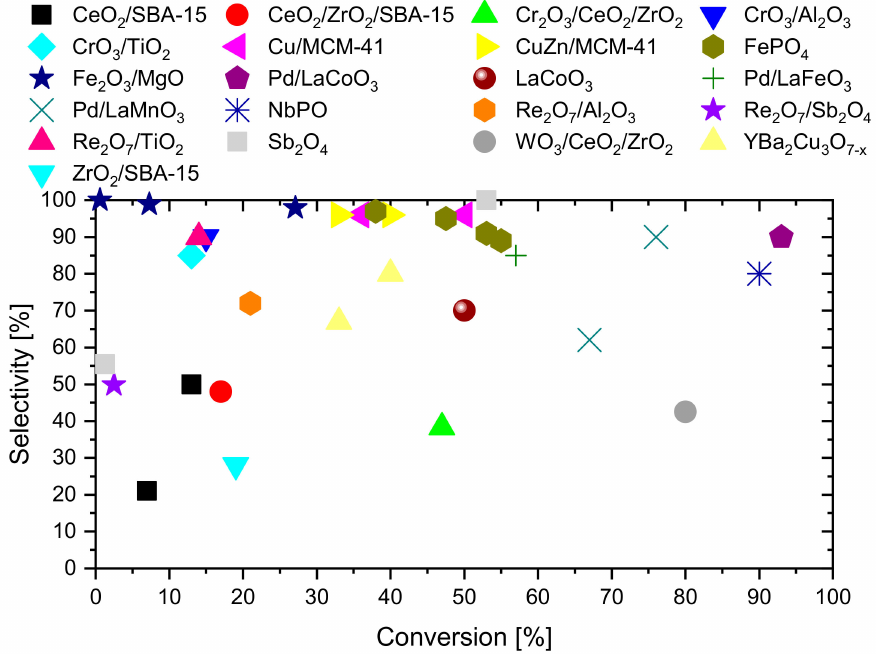
Figure 49. Summary of catalytic test results in the literature shown as selectivity vs. conversion for catalysts not containing V or Mo shown